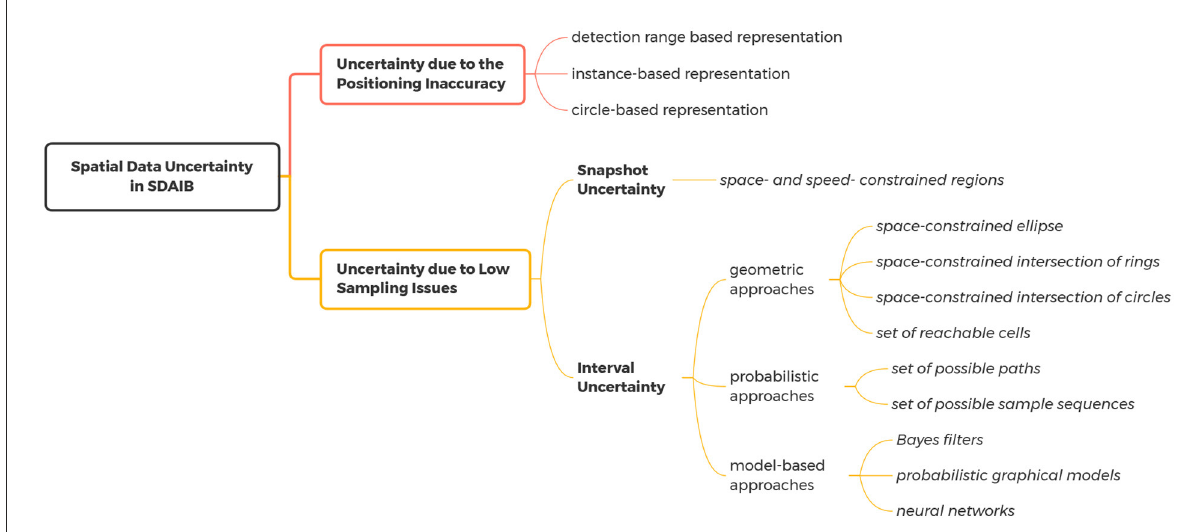
analyses, especially for the indoor scenes that usually pose high requirements on the precision of the spatial